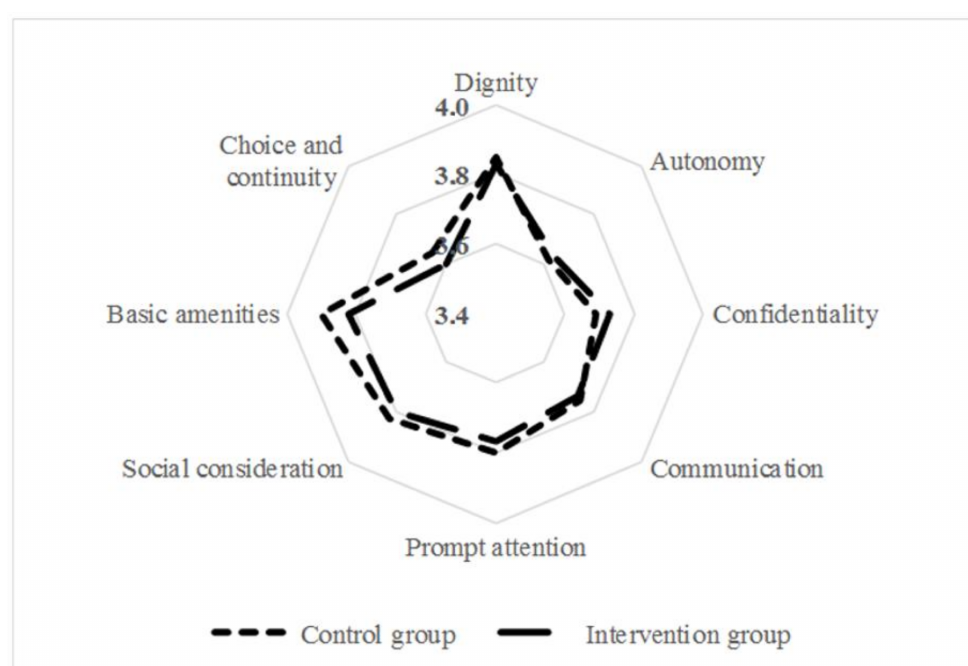
Figure 5. Women’s mean perspectives on received maternal care in the control and intervention groups.